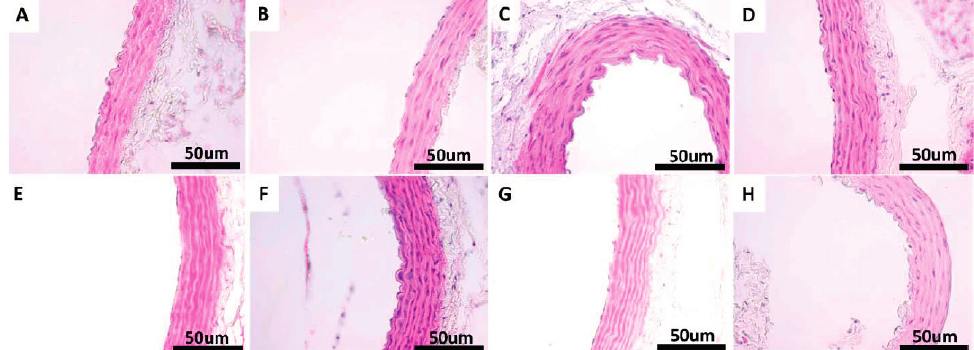
Figure 7. Morphology of the aorta of rats in: CS group: non-diabetic sedentary untreated control rats ( A ); CE group: non-diabetic trained untreated control rats ( B ); CSQ group: non-diabetic sedentary control rats treated with quercetin ( C ); CEQ group: non-diabetic trained control rats treated with quercetin ( D ); DS group: diabetic sedentary control rats ( E ); DE group: diabetic trained untreated control rats ( F ) and DSQ group: diabetic sedentary rats treated with quercetin ( G ); DEQ group; diabetic trained rats treated with quercetin ( H ). H & E stain original magnification of 40×. Scale bar = 50 μ